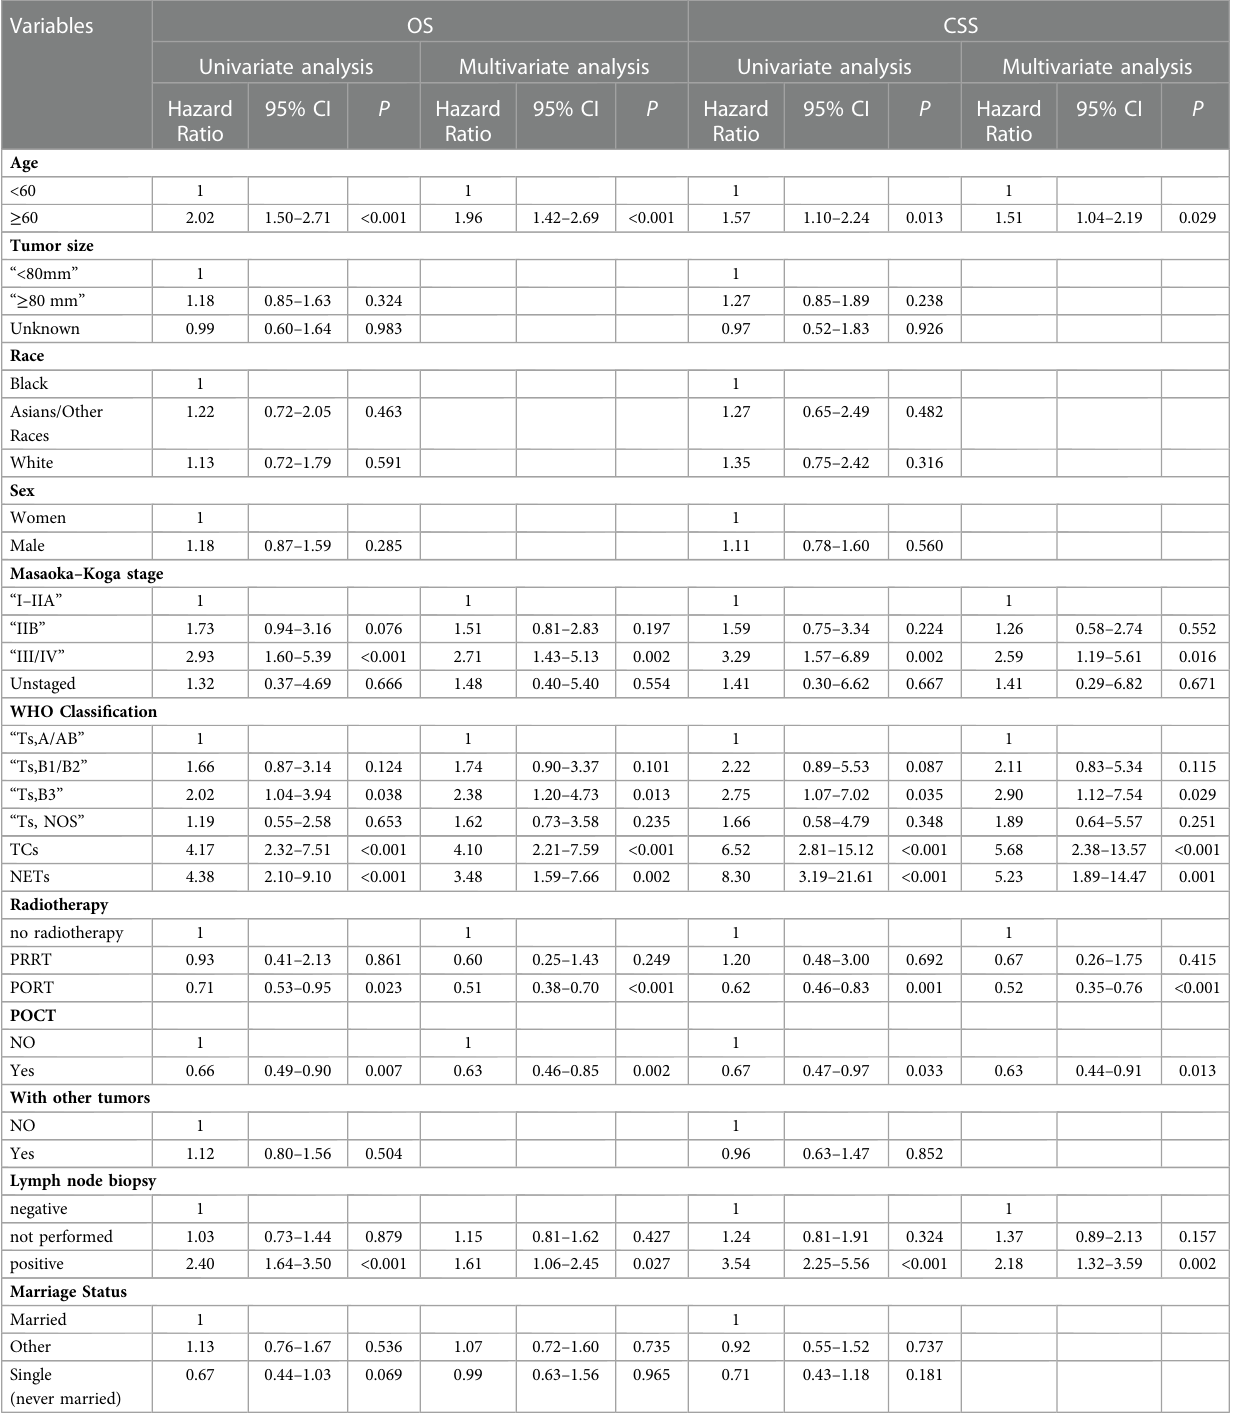
TABLE 3 Univariate and multifactorial analyses of propensity score matching affecting overall survival in patients undergoing surgery for thymic epithelial tumors. Variables OS CSS Univariate analysis Multivariate